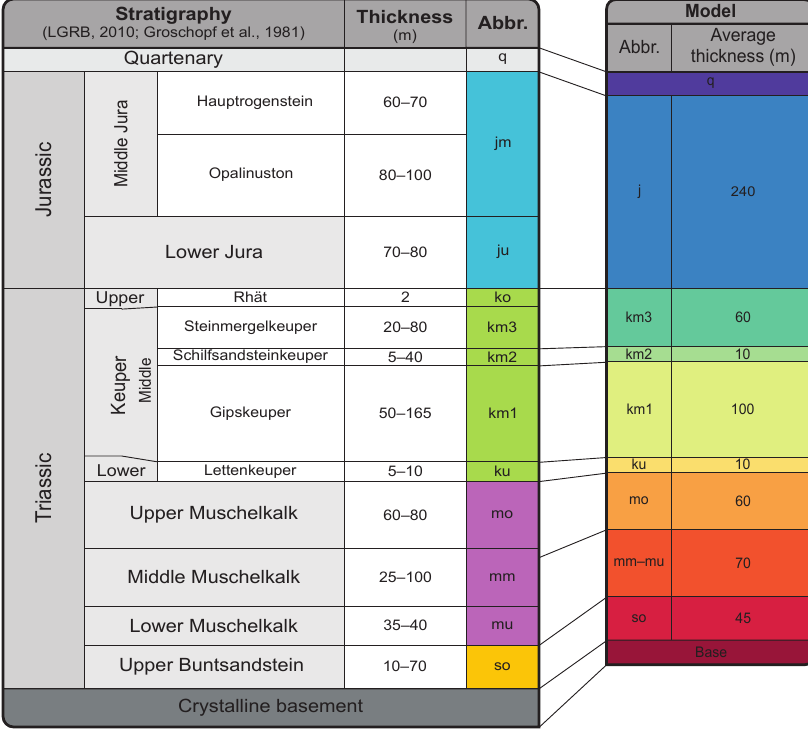
data density and structural model complexity increase